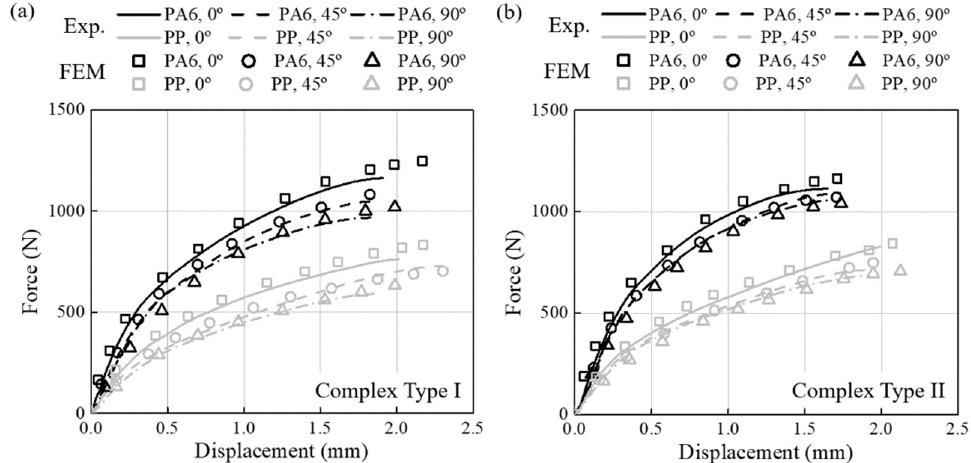
Figure 16. Load-displacement curves of PA6-CF and PP-CF materials (line: experimental data, scatter: